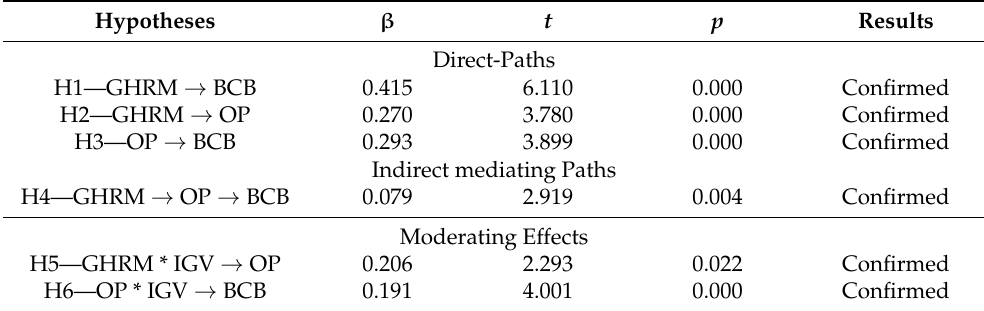
Table 6. Hypotheses testing (inner model results).